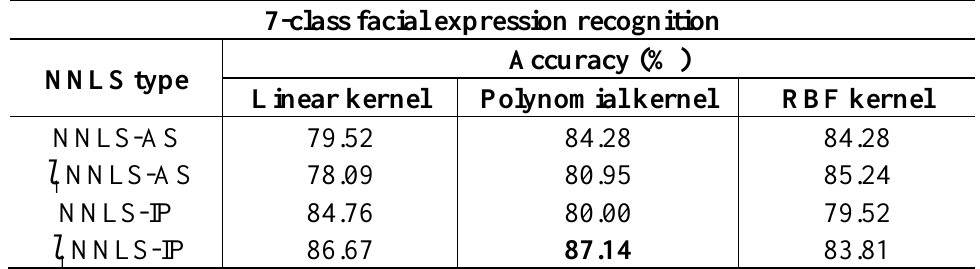
Table 1. Recognition results obtained by NNLS-based classifier with the raw pixels.